Question: What visual encoding does this figure use to show its data?
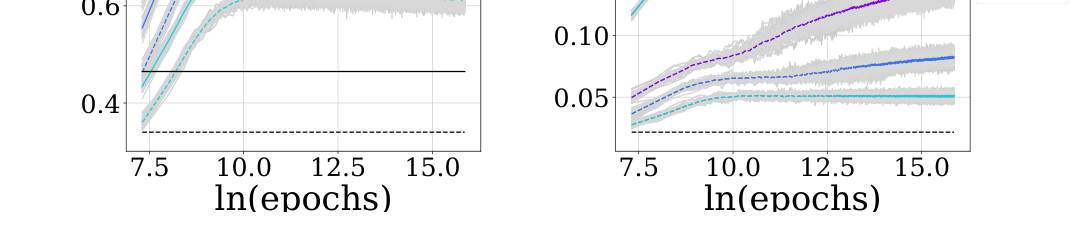
Answer: line